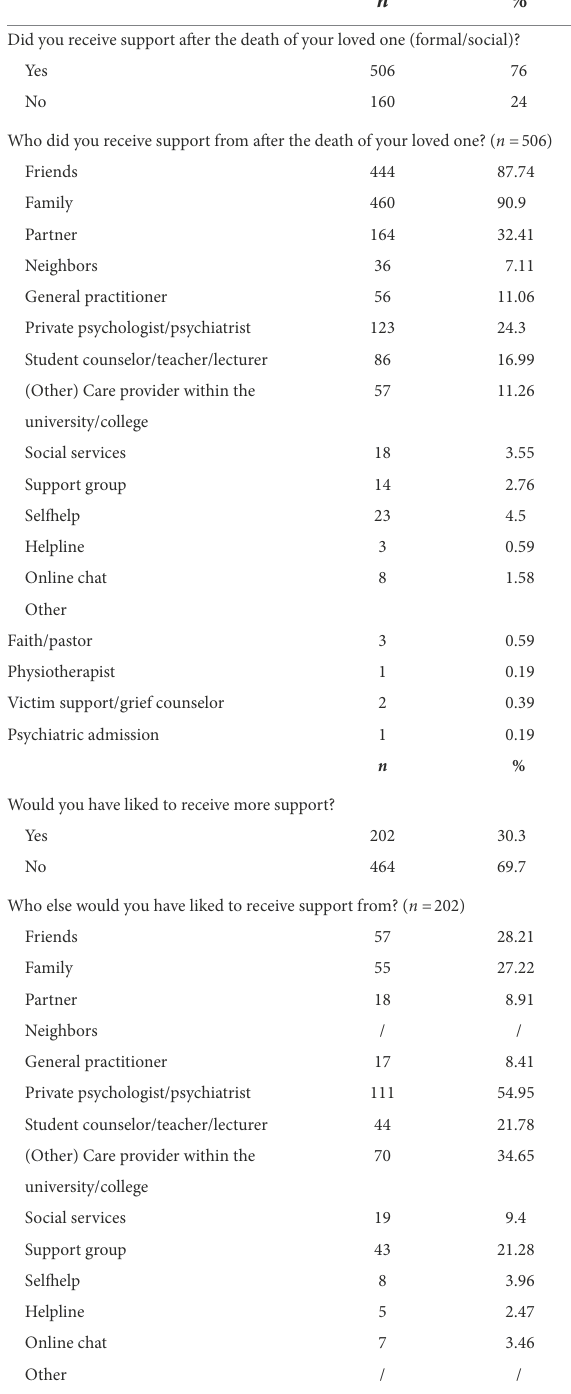
TABLE 1 Received and desired